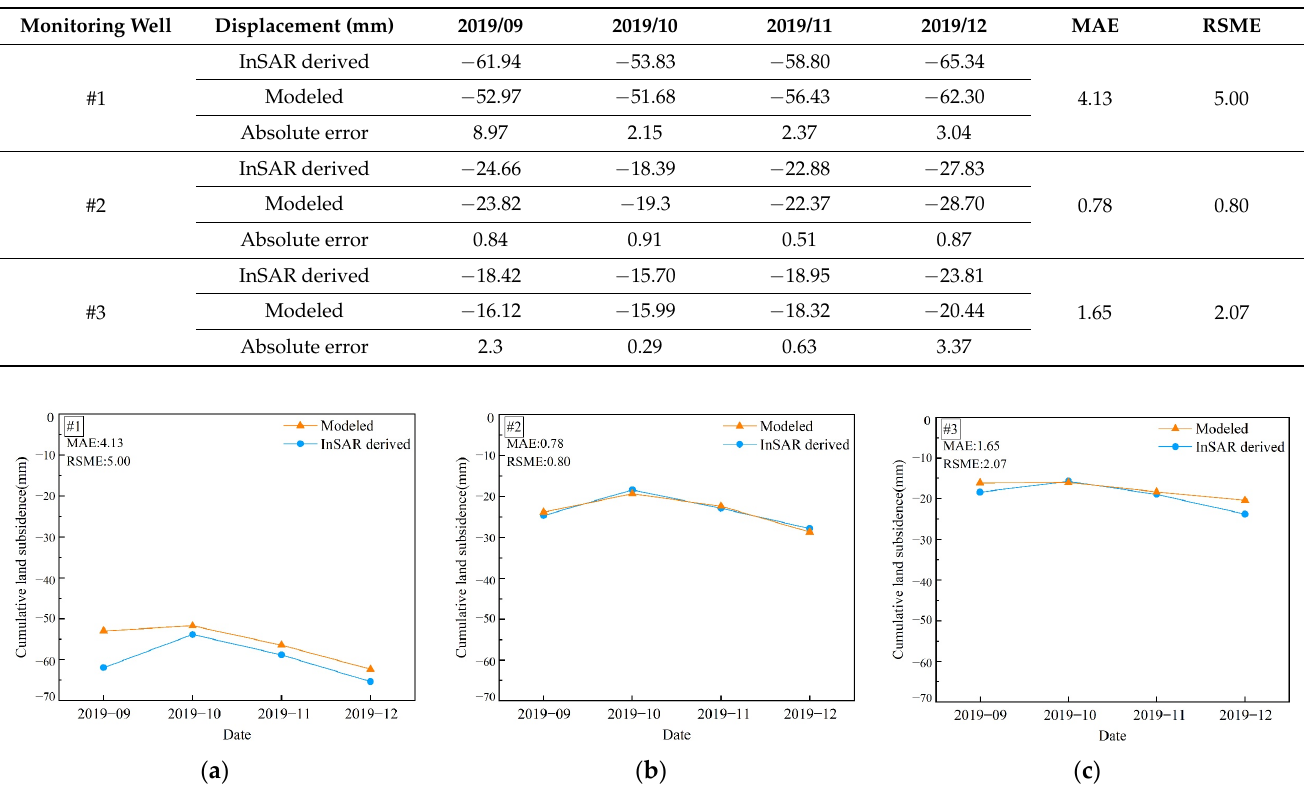
Table 2. Comparison between SAR-based values and simulated results for three wells.